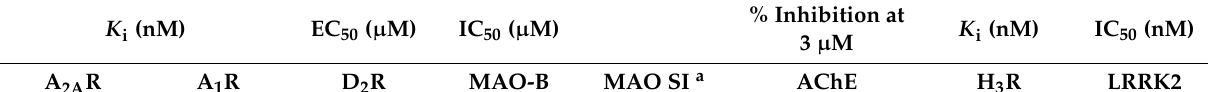
Table 1. Affinities and potencies of novel compounds at certain molecular targets (numeration according to Figure